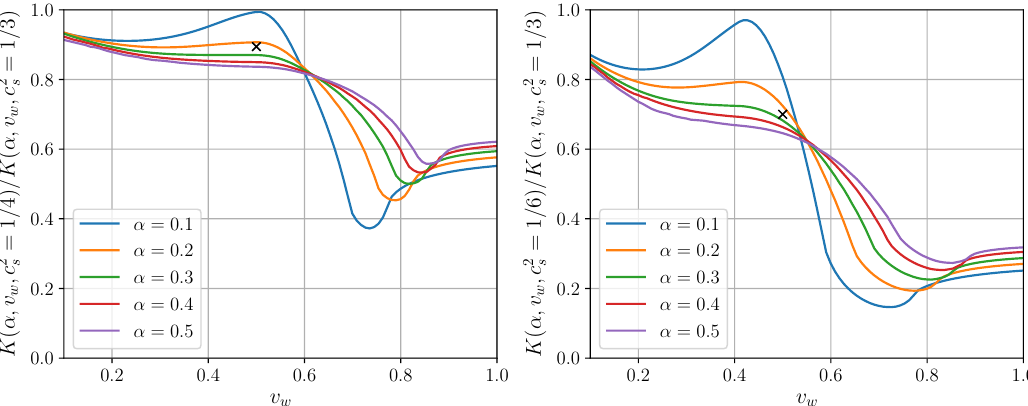
Figure 16 . Plots of the effect of varying stiffness of the equation of state ∂p/∂e on the kinetic energy fraction K for α = 0 . 1 , 0 . 2 , 0 . 3 , 0 . 4 , and 0 . 5 as a function of the wall speed v w . This is displayed as a ratio of the kinetic energy fraction for two different equations of state ( ∂p/∂e = 1 / 4 , 1 / 6 ) to the kinetic energy fraction of the conformal stiffness ∂p/∂e . Black crosses have been placed on each graph to show a reference point with v w = 0 . 5 and α = 0 . 25